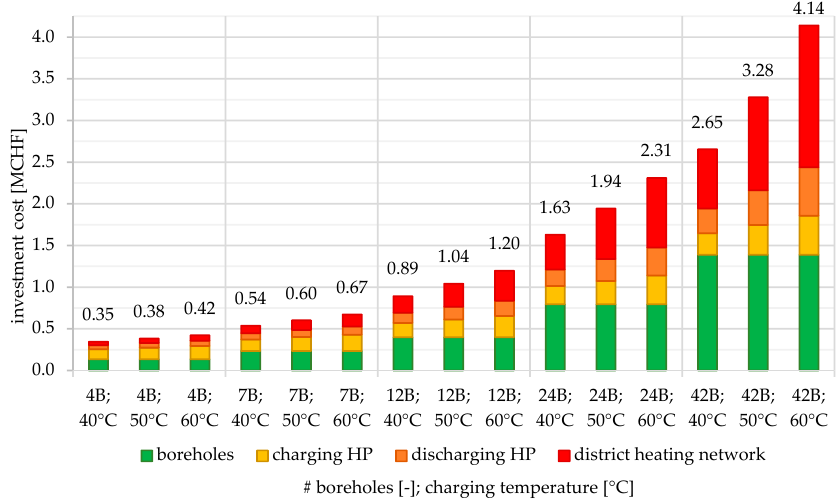
Figure 34. Investment cost for each modeled configuration and charging temperature. The color-coded bars represent the proportion of the total investment cost for each configuration and charging temperature modeled. The borehole installation and district heating network bear the largest proportion of the investment cost.